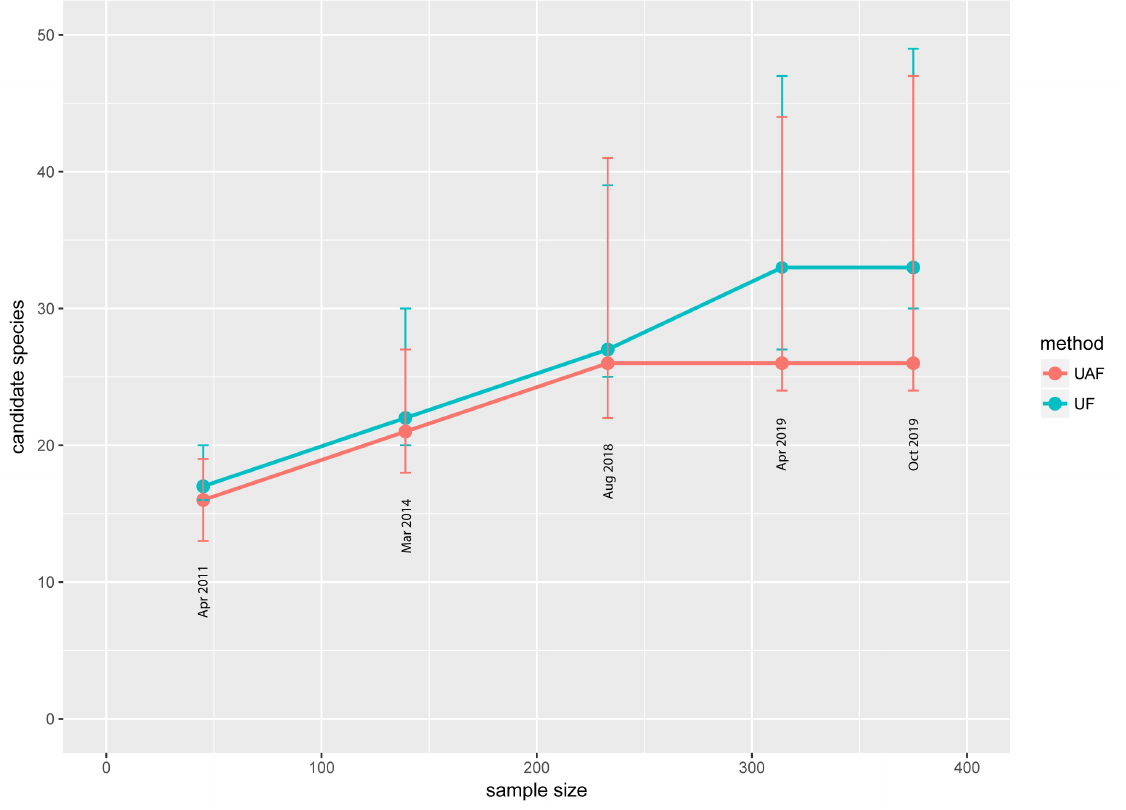
Fig. 8. Numbers of candidate species from example Poisson-tree-process (PTP) analyses using either unfiltered (UF) or with unique haplotype filtering (UHF) from MrBayes trees from COI barcodes ( y -axis) as sample sizes of selected barcoded individuals increased through time ( x -axis). All analyses were re- run retrospectively with the same outgroup and model settings (see text). PTP analyses using highest Bayesian support values to fit the models (error bars for 95% confidence intervals from PTP